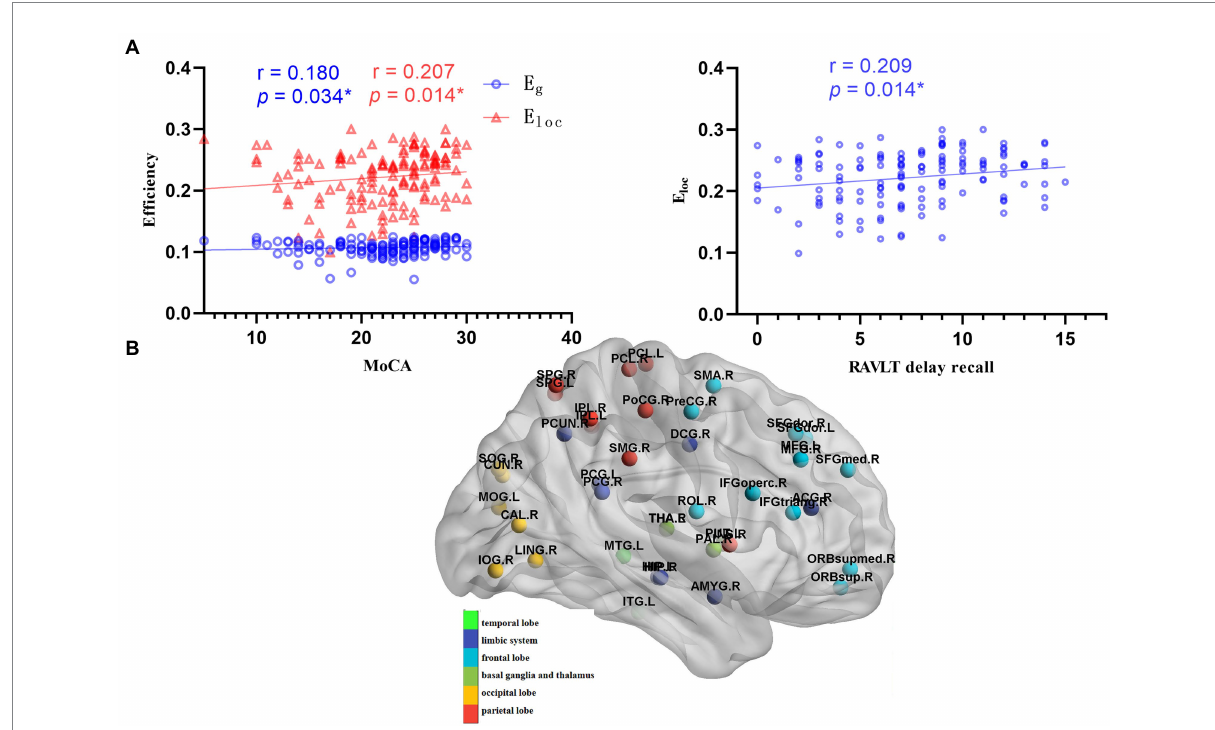
FIGURE 3 Correlations between global metrics and cognition. (A) Correlations between global metrics (E g and E loc ) and cognitive scales (MOCA and RAVLT delay recall); Statistically significant Spearman correlation coefficients ( n = 139, p < 0.05) are shown (MOCA: Montreal cognitive assessment; RAVLT: Rey auditory verbal learning test). (B) Schematic diagram of the differential node efficiency among the LAN, RAN, and HC groups. AN patients showed a more extensive decrease of node efficiency, mainly in the frontal lobe, occipital lobe, parietal lobe, limbic system, basal ganglia,